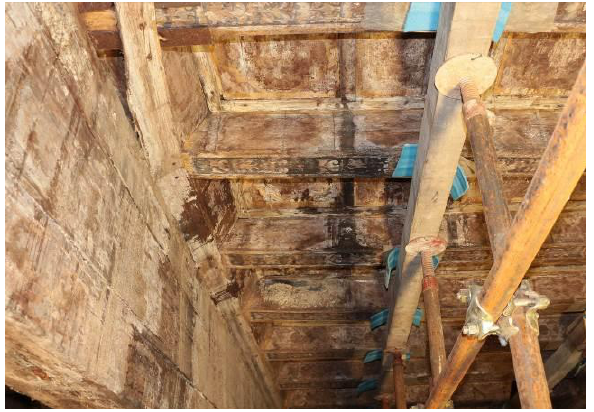
Figure 14: Wood decay, main hall.